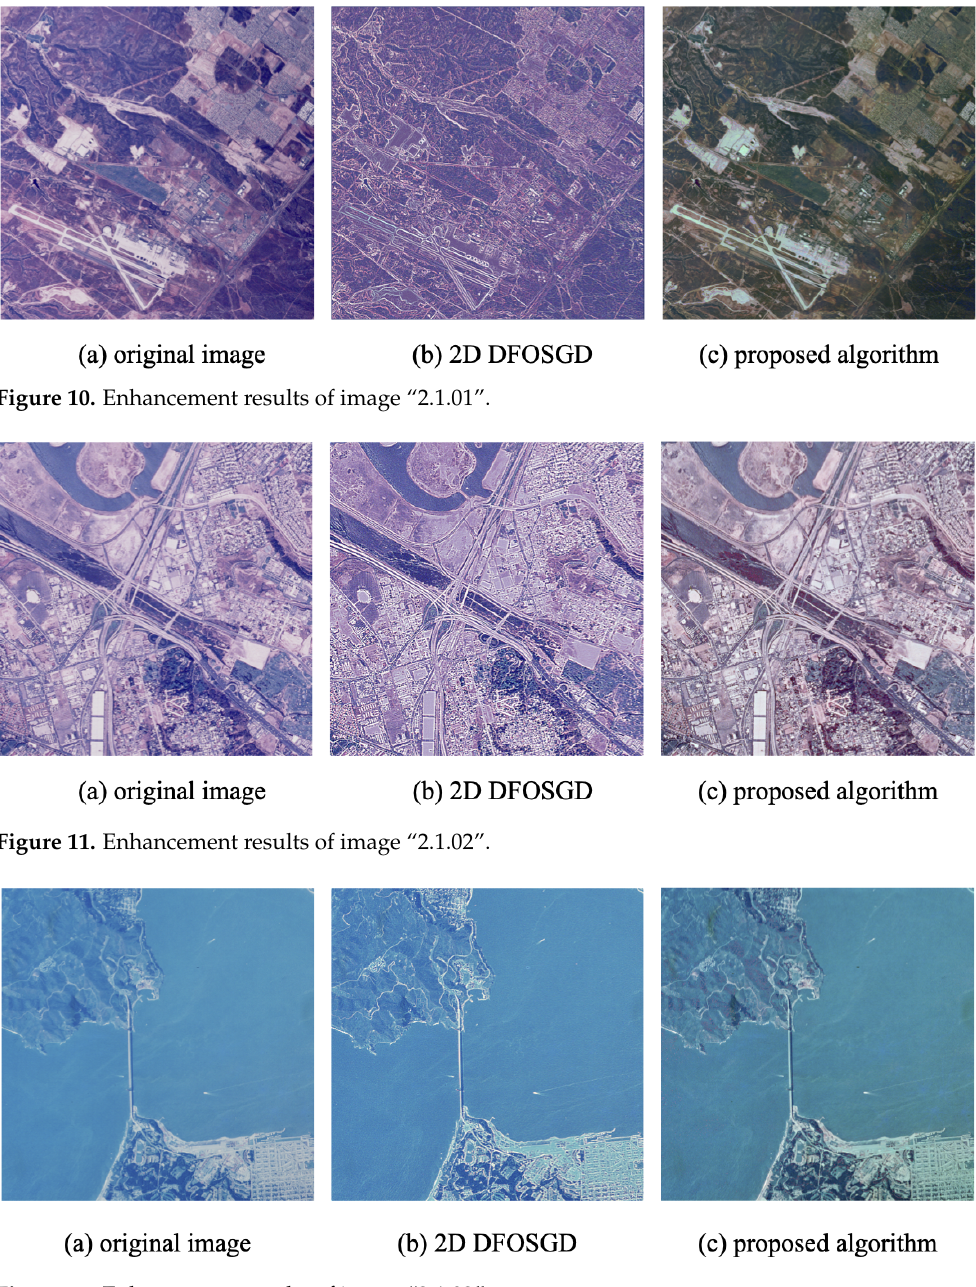
Figure 12. Enhancement results of image